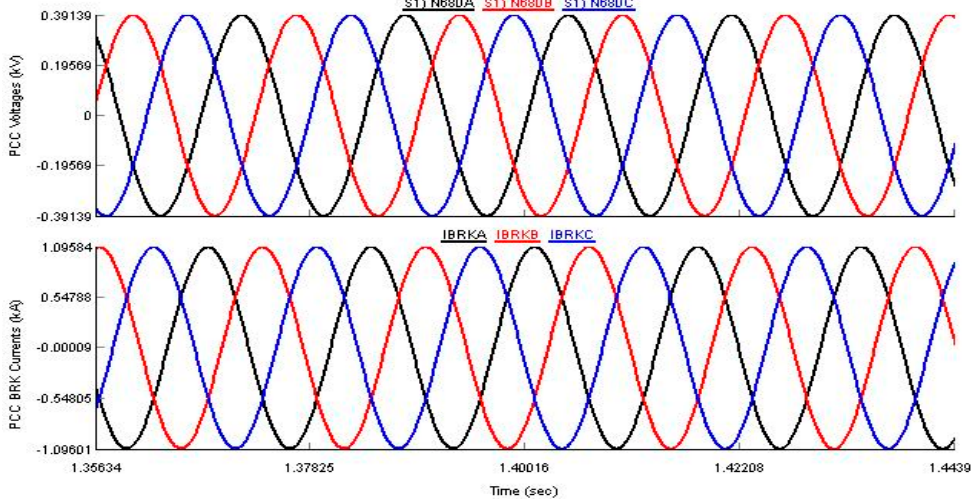
Figure 10. The corresponding grid voltage and breaker currents.